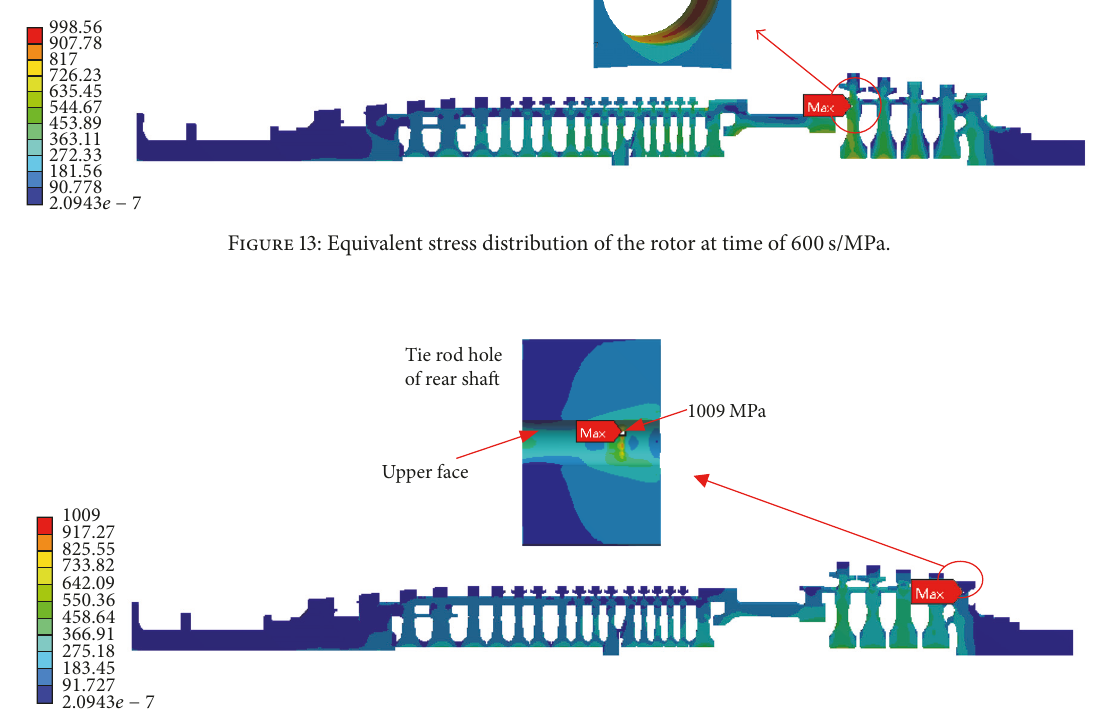
Figure 14: Equivalent stress distribution of the rotor at time of 6000